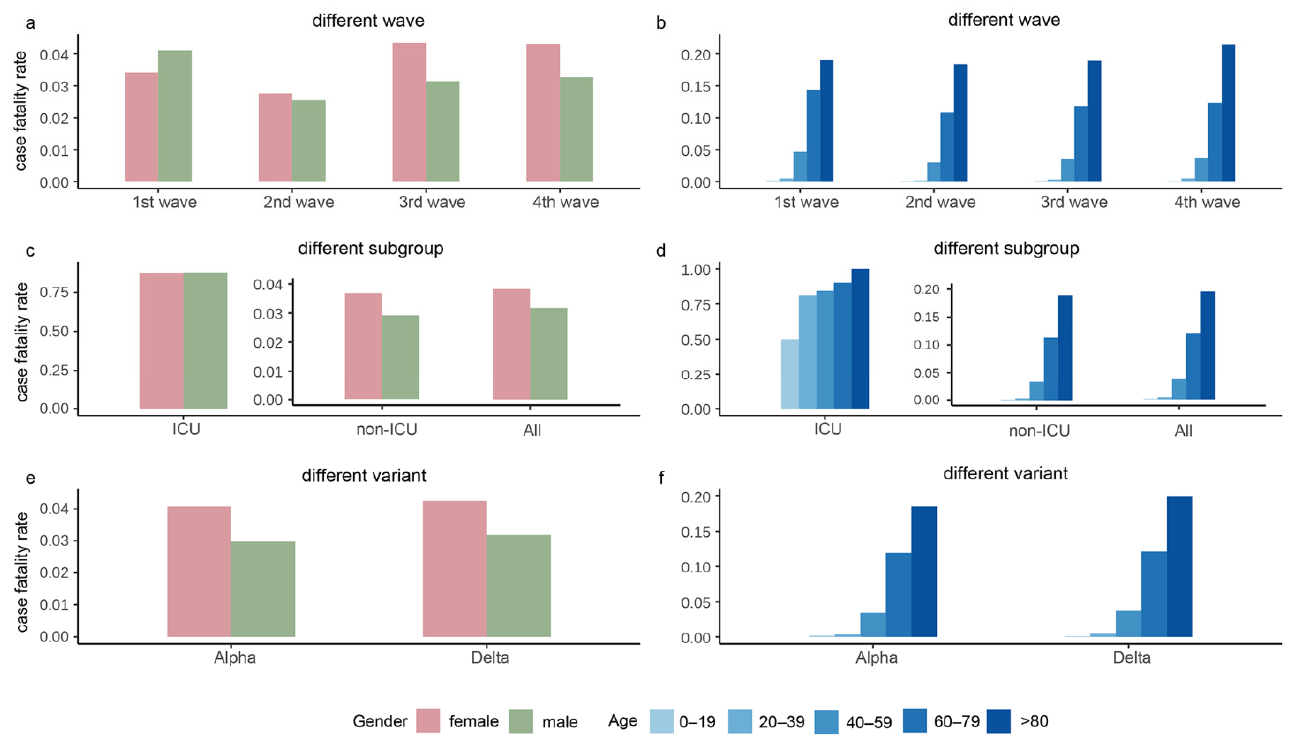
Figure 3. The case fatality rates in the four waves of the pandemic, intensive care unit (ICU)/non-ICU subgroups, and the Alpha and Delta variants. Panels ( a , b ) show the case fatality rates grouped by gender and age, respectively, in the four waves. Panels ( c , d ) display the case fatality rates grouped by gender and age, respectively, in ICU, non-ICU, and all cases. Panels ( e , f ) exhibit the case fatality rates grouped by gender and age, respectively, in the period of Alpha and Delta variants.